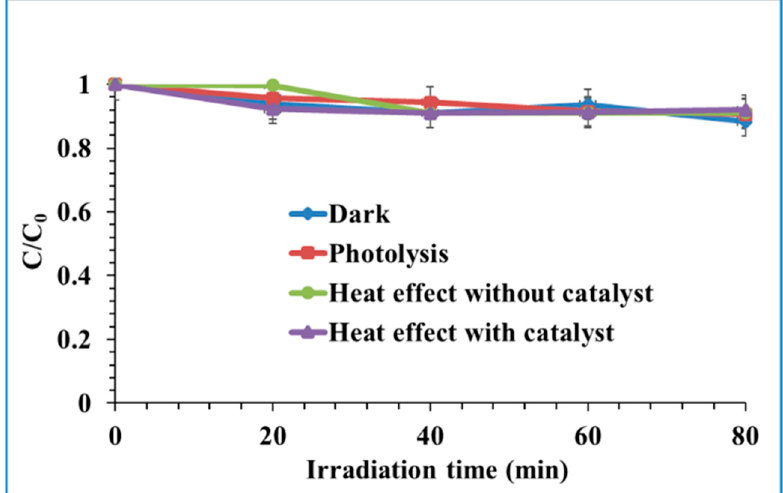
Figure 15. Dark effect (with 1 g/L Mo/HRTiO 2 ), photolysis, heat effect with 1 g/L Mo/HRTiO 2 , and heat effect without photocatalyst over the degradation of 50 mg/L initial IBU concentration under natural (unmodified) pH ~ 4, and 365 nm UV irradiation.